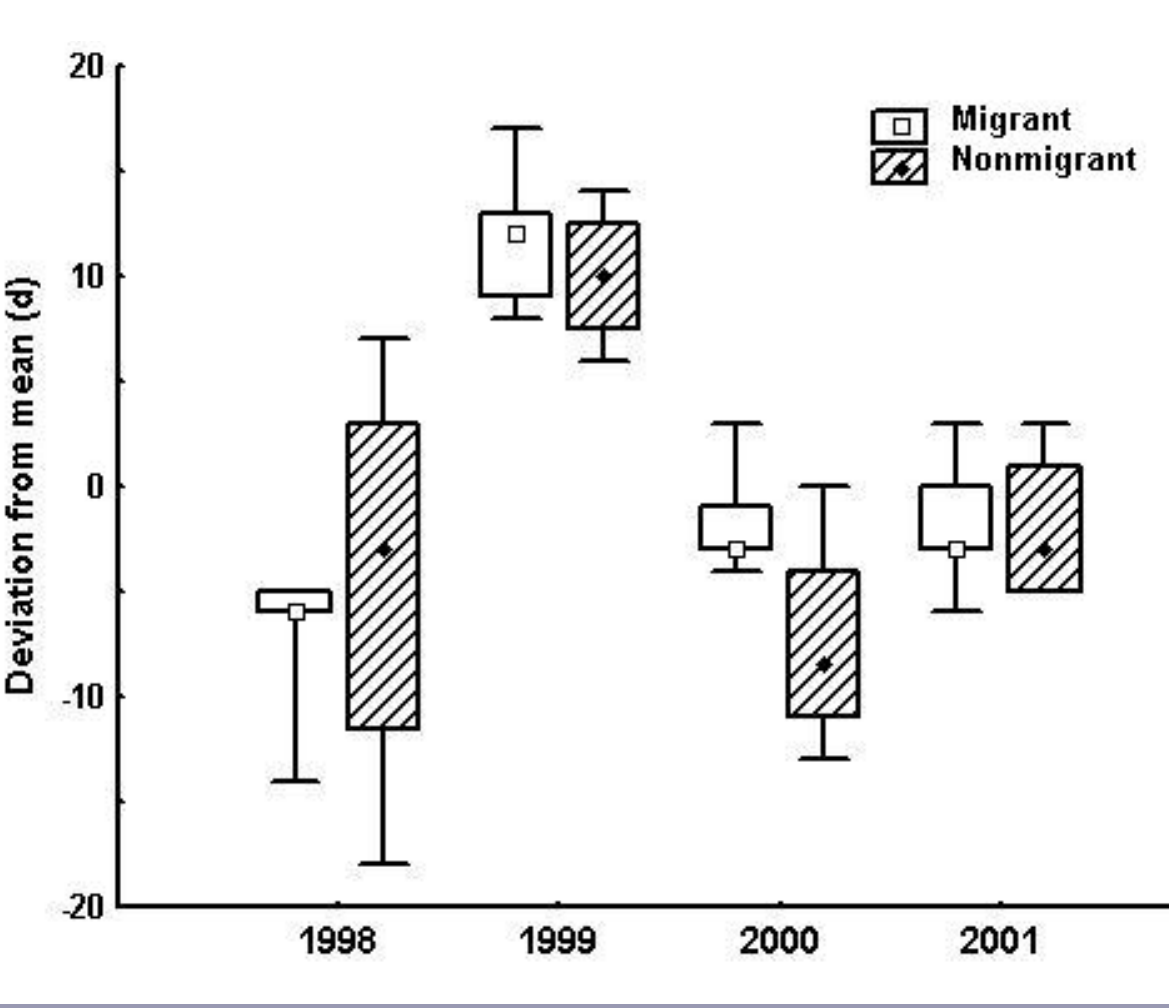
Fig. 3 . Median dates of capture of hatching-years for six species qualifying in all years, separated into migrants and nonmigrants. The symbols represent the median, the boxes contain a range of 25–75%, and the whiskers illustrate the